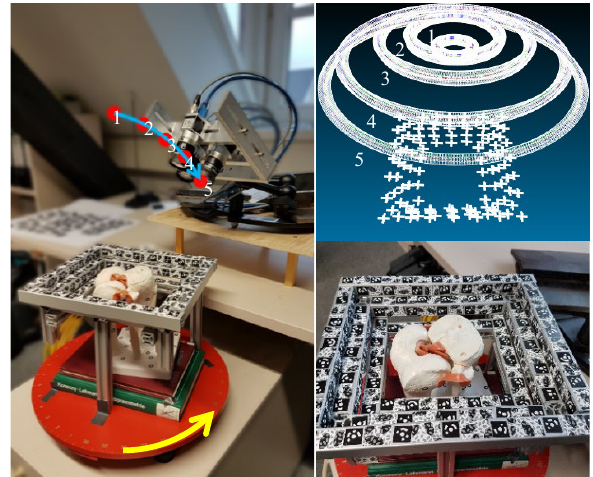
Figure 6. Left: Experimental setup. The trinocular system observes the test-field and the artificial knee joint from five positions (red dots, blue arrow). The test-field rotates in 1° steps around its vertical axis (yellow